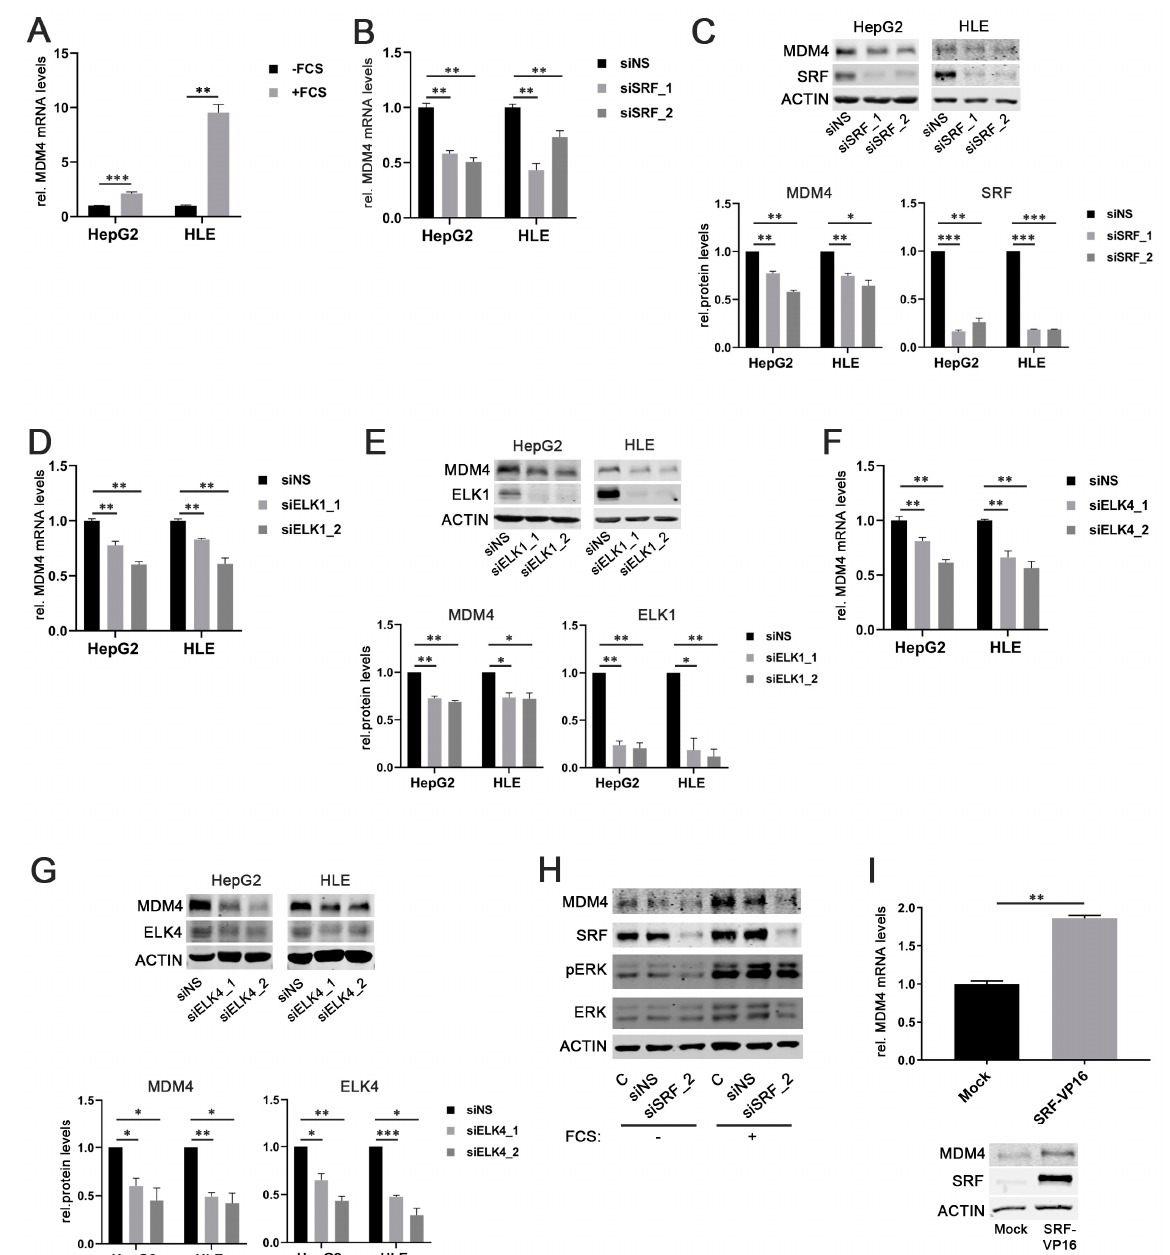
Figure 2. SRF, ELK1, and ELK4 regulate MDM4 expression in HCC cell lines. ( A ) Increased MDM4 mRNA levels in HepG2 and HLE cell lines following fetal calf serum (FCS) stimulation compared to starved control cells. ( B ) MDM4 mRNA and ( C ) protein levels following siRNA-mediated knockdown of SRF compared to control cells transfected with a scrambled, nonsense siRNA (siNS) in HepG2 and HLE cells. ( D ) MDM4 mRNA and ( E ) protein levels following siRNA-mediated knockdown of ELK1 compared to control cells transfected with a scrambled, nonsense siRNA (siNS) in HepG2 and HLE cells. ( F ) MDM4 mRNA and ( G ) protein levels following siRNA-mediated knockdown of ELK4 compared to control cells transfected with a scrambled, nonsense siRNA (siNS) in HepG2 and HLE cells. ( H ) siRNA-mediated knockdown of SRF (siSRF_2) prevents FCS-stimulated MDM4 protein upregulation. ( I ) MDM4 mRNA and protein expression 48 h following transfection of HuH7 cells with an SRF-VP16 expression vector compared to mock transfected control cells. Original western blots are shown in Figures S7 and S8. Data are presented as mean ± SEM. Mann–Whitney U test: * p < 0.05, ** p < 0.01, *** p < 0.001. Abbreviations: siNS—scrambled, nonsense siRNA; siSRF_1/_2, siELK1_1/_2, siELK4_1/_2—siRNA 1 and 2 specifically targeting SRF, ELK1, and ELK4, respectively.